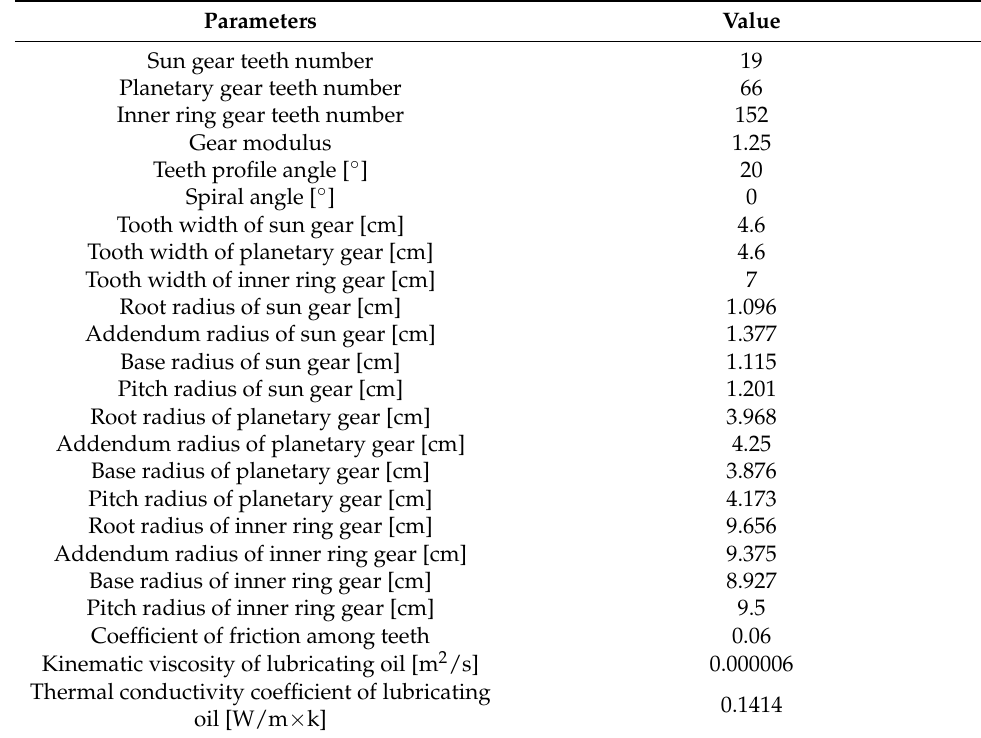
Table 3. Parameters of the